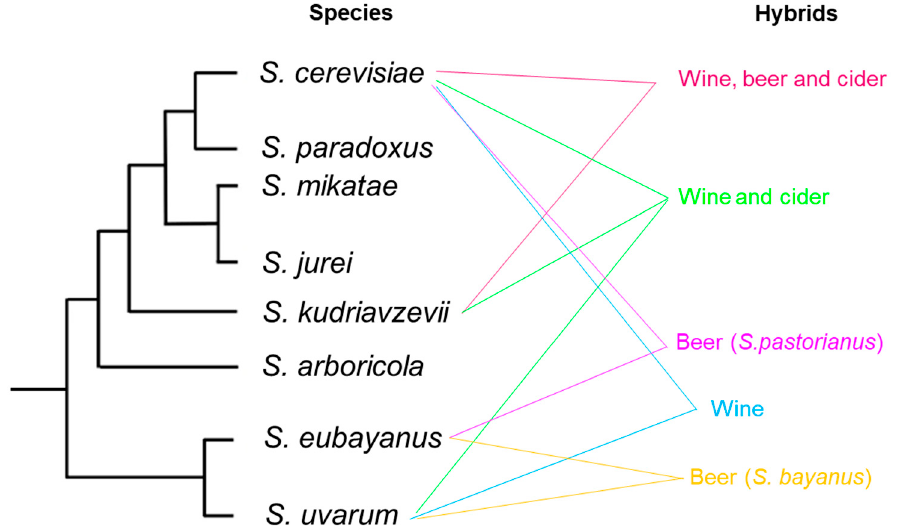
Figure 1. Schematic cladogram indicating phylogenetic relationships within Saccharomyces genus, isolation source and frequently isolated hybrids (adapted from Boynton and Greig, (2014) [38]).